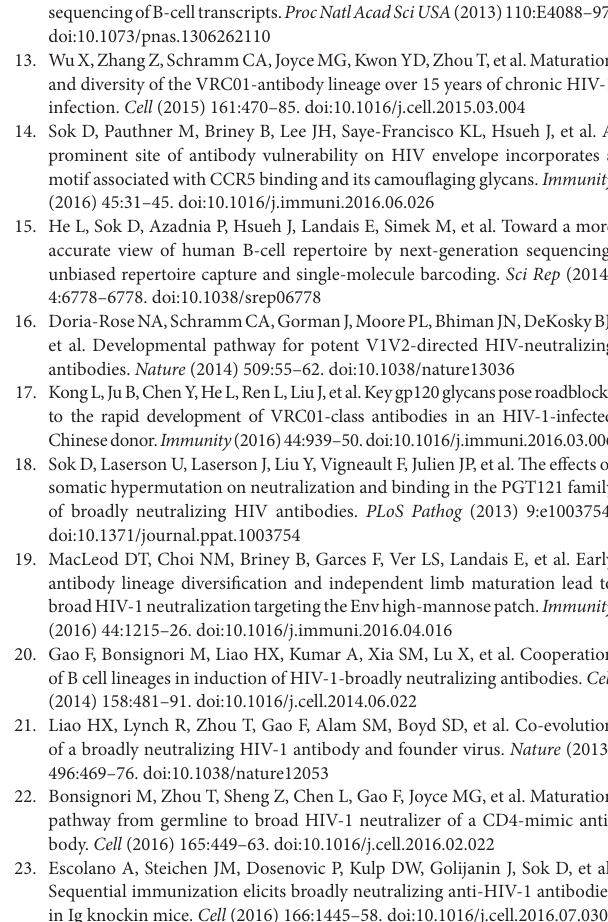
the five scFv libraries obtained from the nanoparticle panning process. Histograms are color-coded according to their antigen panning steps: gray (Pan0), cyan (Pan1), green (Pan2), orange (Pan3), and red (Pan4). FigUre s5 | Identification and characterization of monoclonal antibodies (mAbs) from a diverse donor-17 single-chain variable fragment (scFv) library screened against a clade-C V1V2-ferritin nanoparticle. (a) Six prevalent scFv clones identified by H/L-paired, CDR3-based clustering analysis. (B) Enzyme-linked immunosorbent assay (ELISA) binding of three representative bNAbs of the PGT121 class (PGT121, 124, and 133) and six scFv-derived mAbs (VAb d17 -1–6) to four HIV-1 antigens including a native-like trimer (gp140.664.R1), a gp120- ferritin nanoparticle (gp120-FR), an N332 nanoparticle (1GUT_A_ES-FR), and a V1V2-ferritin nanoparticle (V1V2-FR). For VAb d17 s, ferritin was included in the ELISA as a negative control. EC 50 values are labeled for all ELISA plots except for instances in which the highest OD 450 value is below 0.1 or in the cases of ambiguous data fitting. FigUre s6 | Additional native intermediates (NINs) selected from a focused donor-17 single-chain variable fragment (scFv) library during the trimer panning process. (a) Sequence alignment of HCs with assigned germline genes and WT PGT124 HC. (B) Sequence alignment of LCs with germline gene IgLV3-21 and WT PGT124 LC or PGT133 LC. The three HCDR regions are marked above the sequences, with the mutations with respect to the assigned germline gene colored in red. Below the sequence alignment, asterisk (*) indicates identical residues, colon (:) indicates residues with strongly similar properties, and period (.) indicates residues with weakly similar